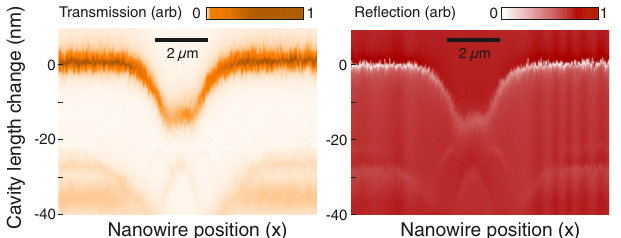
FIG. 10. Nanowire-based scanning probe exploration of the intracavity field and higher-order transverse modes. Cavity IR transmission and reflection stacks are measured while scanning its total length with the slow piezo and moving the nanowire across the optical mode ( x axis). For this cavity configuration, in addition to the TEM 00 mode (top), higher-order modes are also visible (bottom), and cross-couplings can be induced by the nanowire diffusion.